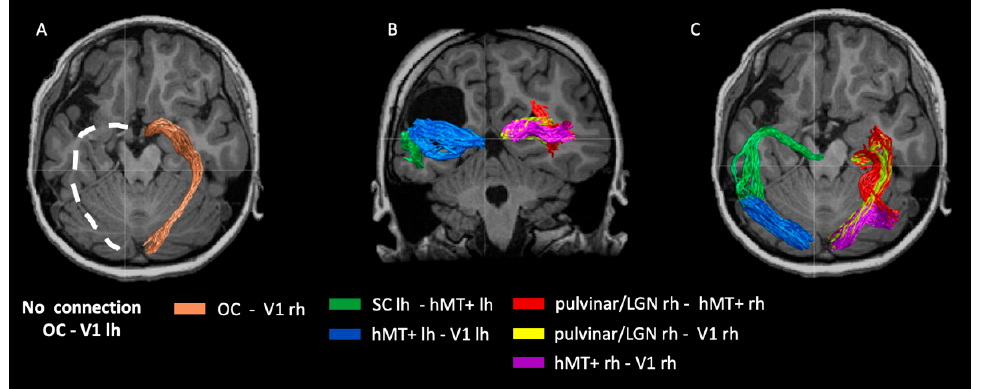
Figure 4 . Diffusion tractography in patient IB . ( A ) OC connects with V1 only in the intact hemisphere. ( B,C ) Importantly, a connection between the SC and hMT+ that extends to V1 is found in the lesioned hemisphere. Visual white matter bundles in the intact and healthy hemisphere shown in the coronal ( B ) and axial ( C ) views. Rh and lh indicate the location of the ROI in the right or in the left hemisphere respectively.